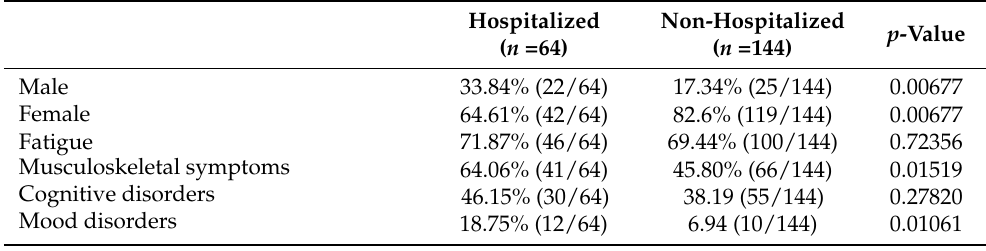
Table 2. Comparison results between hospitalized and non-hospitalized Long COVID patients.